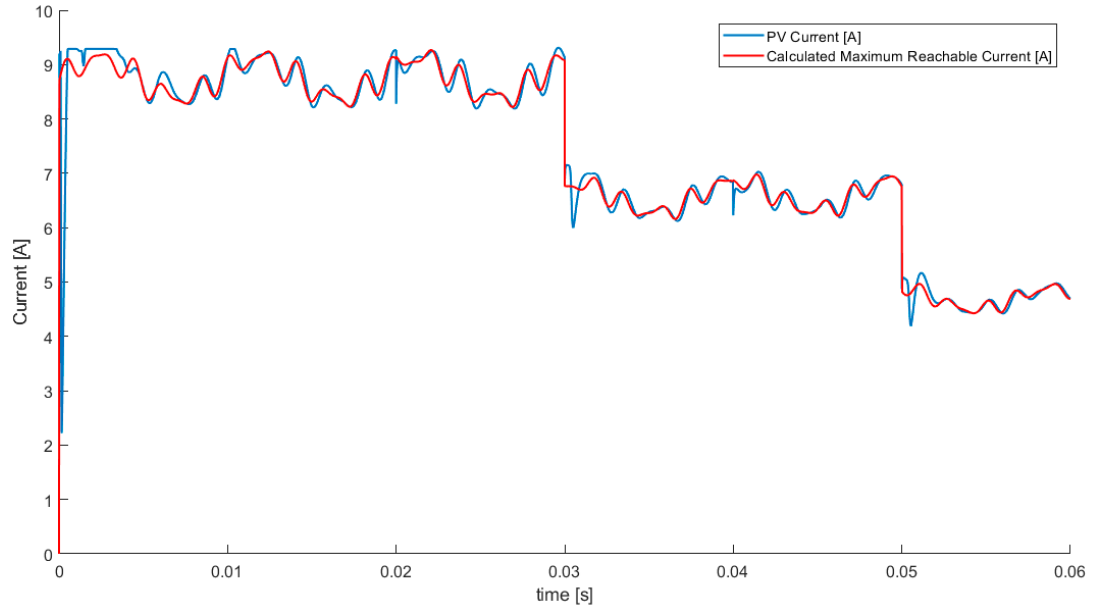
Figure 15. Evolution of PV Current over time.